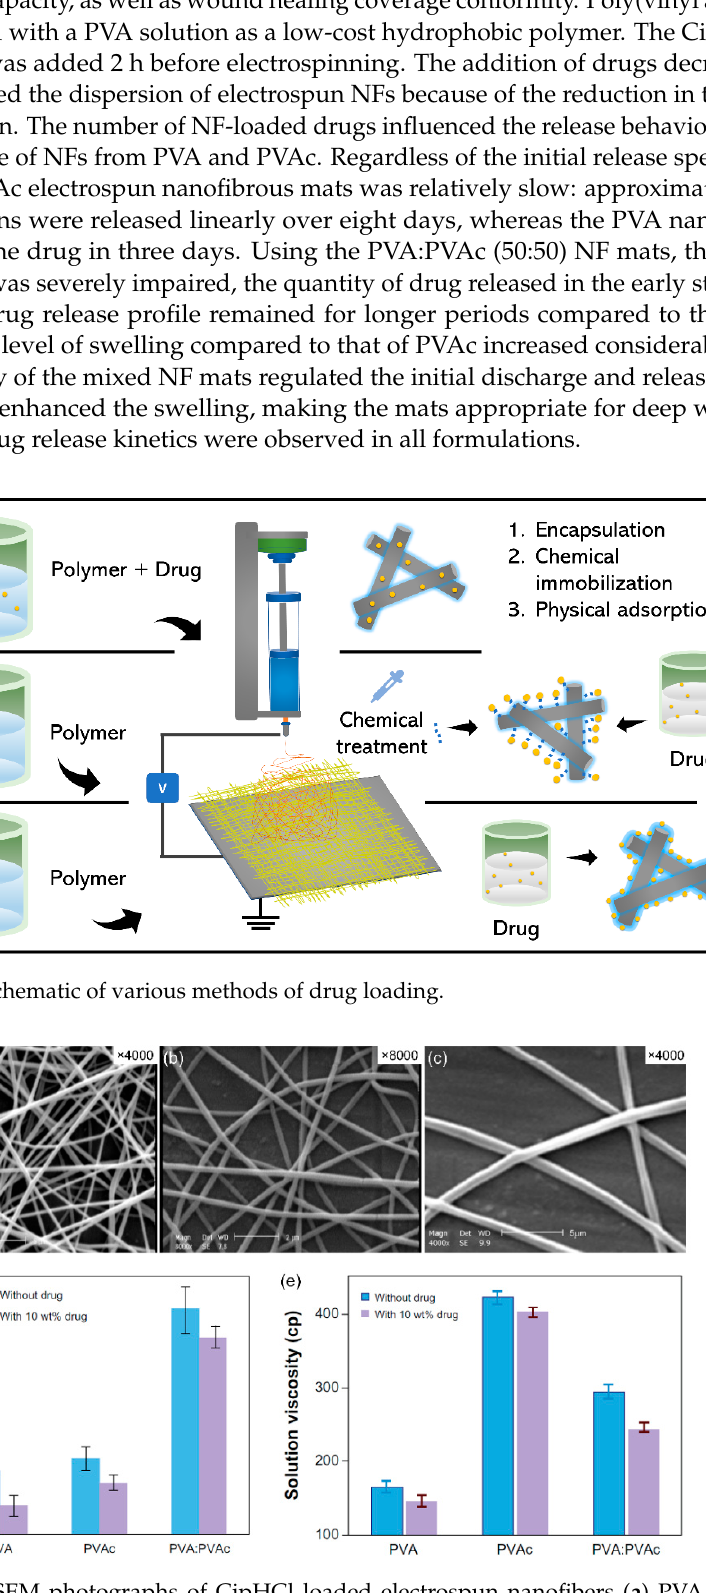
Figure 7. SEM photographs of CipHCl loaded electrospun nanofibers ( a ) PVA, ( b ) PVAc, and ( c ) 50:50 blend of PVA/PVAc. Effect of CipHCl on ( d ) the diameter of nanofibers and ( e ) the solution viscosity. Reproduced with permission from [68], Copyright © 2021 Jannesari et al., publisher and licensee Dove Medical Press Ltd., Macclesfield, United Kingdom.